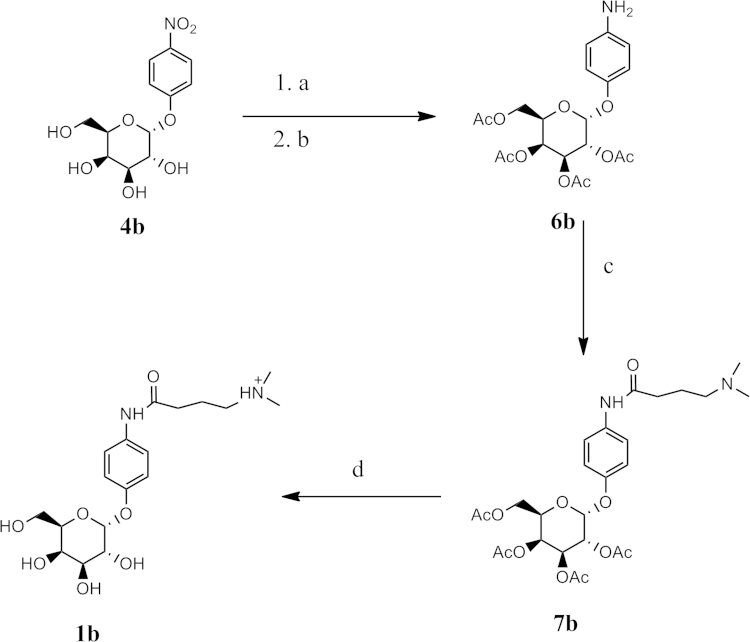
Reagents: (a) Ac2O, Pyridine, rt (b) Amm. Formate, Pd-C, MeOH, EtOAc (c) (CH3)2N(CH2)3CO2H, DCC, DMAP, CH2Cl2 (d) NaOMe/MeOH.